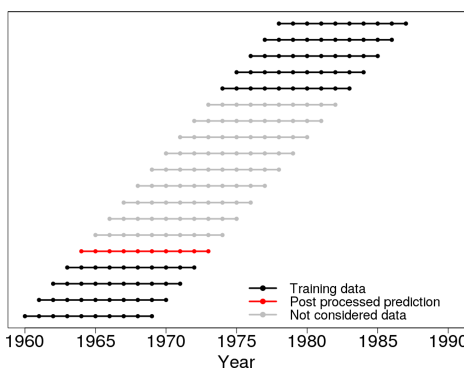
Figure B1. Schematic overview of the applied cross-validation pro- cedure for a decadal climate prediction, initialized in 1964 (red dot- ted line). All hindcasts which are initialized outside the prediction period are used as training data (black dotted lines). A hindcast which is initialized inside the prediction period is not used for train- ing (gray dotted